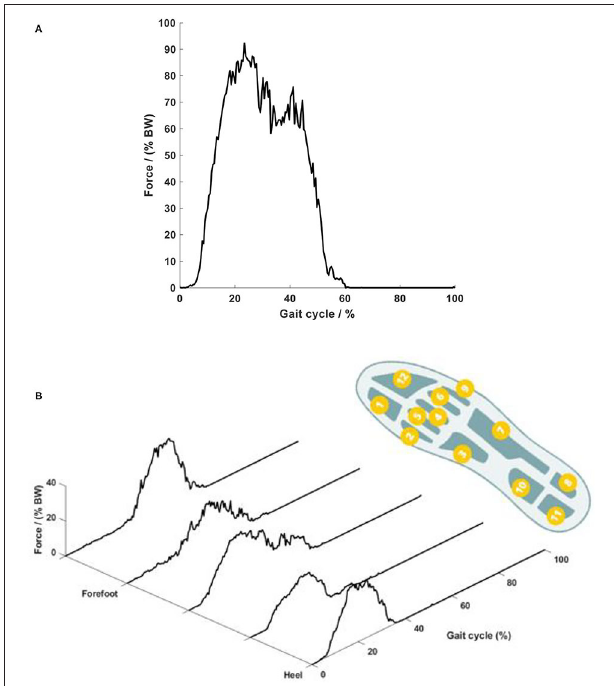
FIGURE 12 | Plantar force on the foot sole. (A) Temporal curve of the overall force and (B) force on different plantar areas. The right foot sole shape shows the location of the 12 pressure sensors. Each curve in the plot shows the summation of the pressures in the four corresponding foot